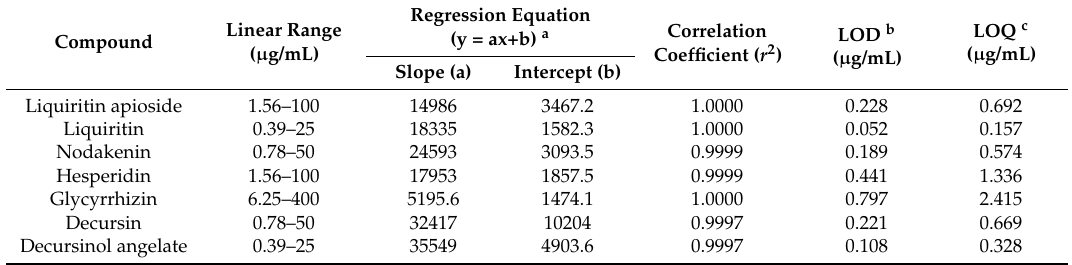
Table 1. Linear range, regression equation, correlation coefficients, LODs, and LOQs for